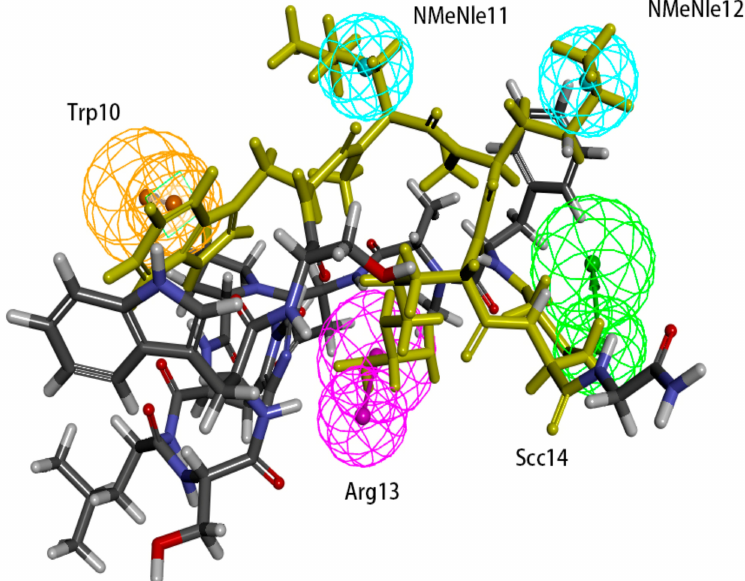
Figure 8. Superposition between Hypo 1A and peptide-57. As the figure shows, the hydrophobic point is blue, the hydrogen bond donor is purple, the hydrogen bond acceptor is green, and the aromatic ring point is orange. The labelled residues are